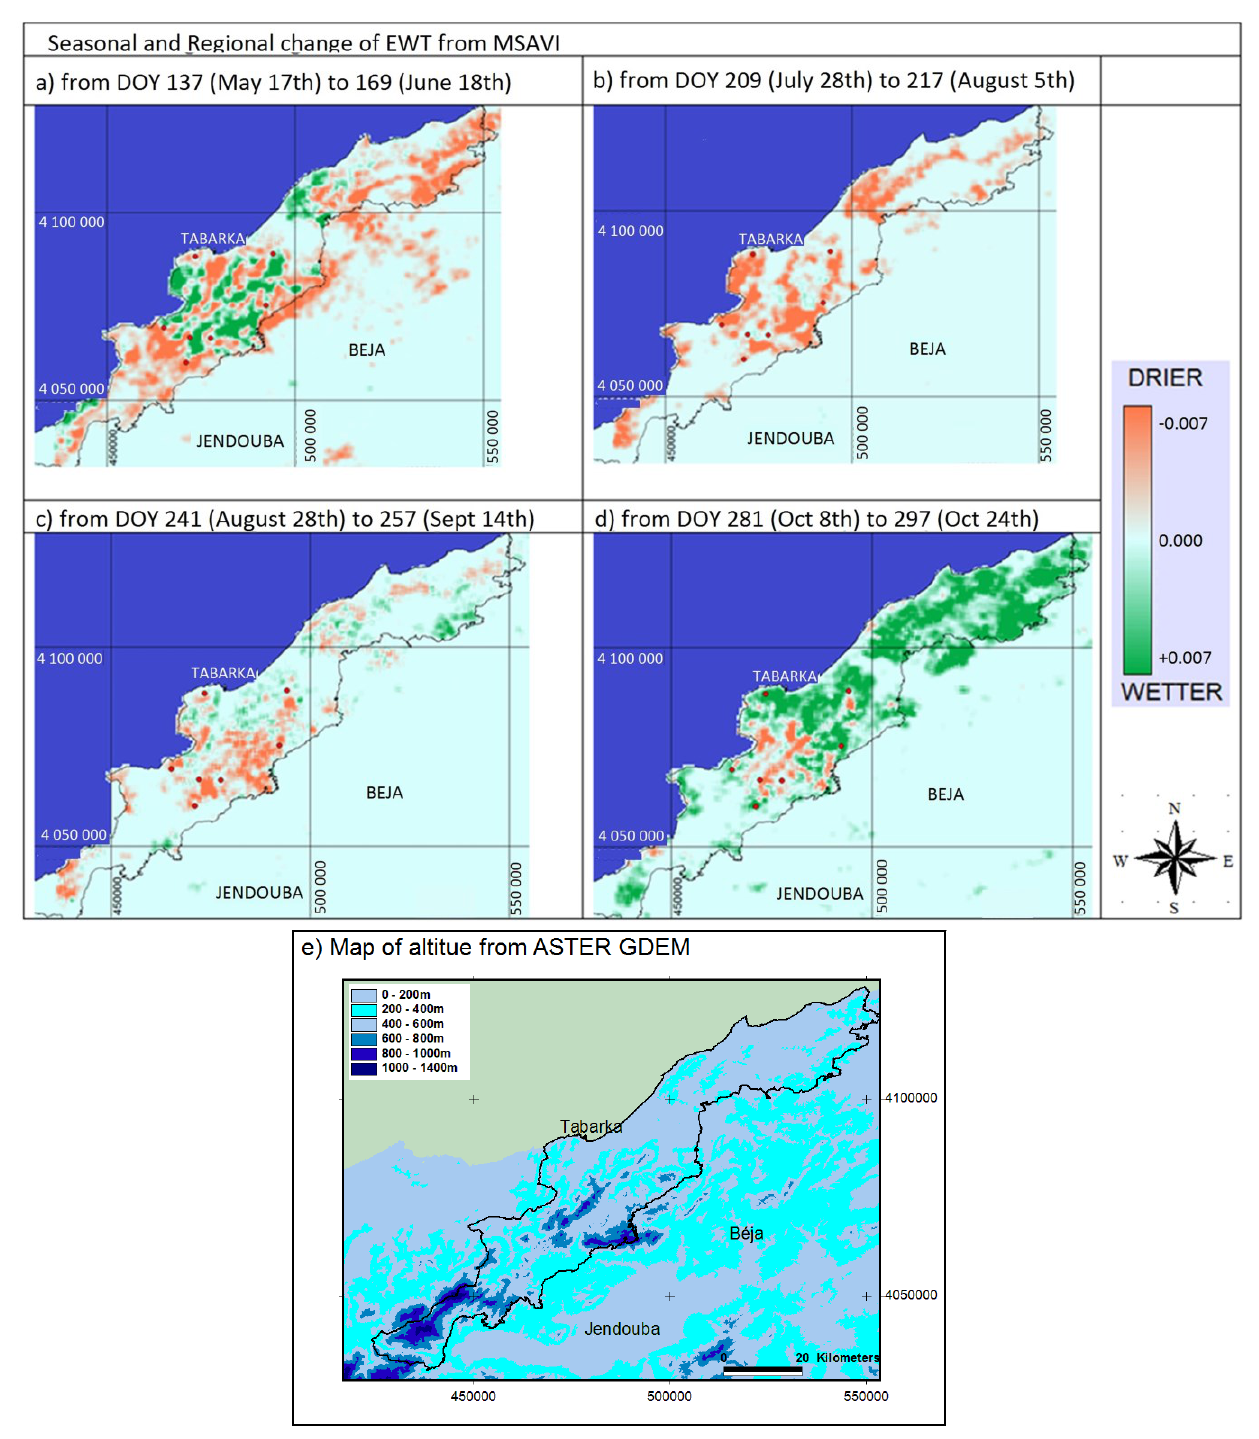
Figure 8. Time course of regional maps of EWT CAN change (g·cm −2 ) in spring (( a ); between DOY 137 and 169), mid-summer (( b ); between DOY 209 and 217), late summer (( c ); between DOY 241 and 257) and early fall (( d ); between DOY 281 and 297). Reddish colors indicate drier conditions along the period, and greenish colors indicate wetter conditions along the period. ( e ) Map of the altitude of the Kroumirie region (processed from